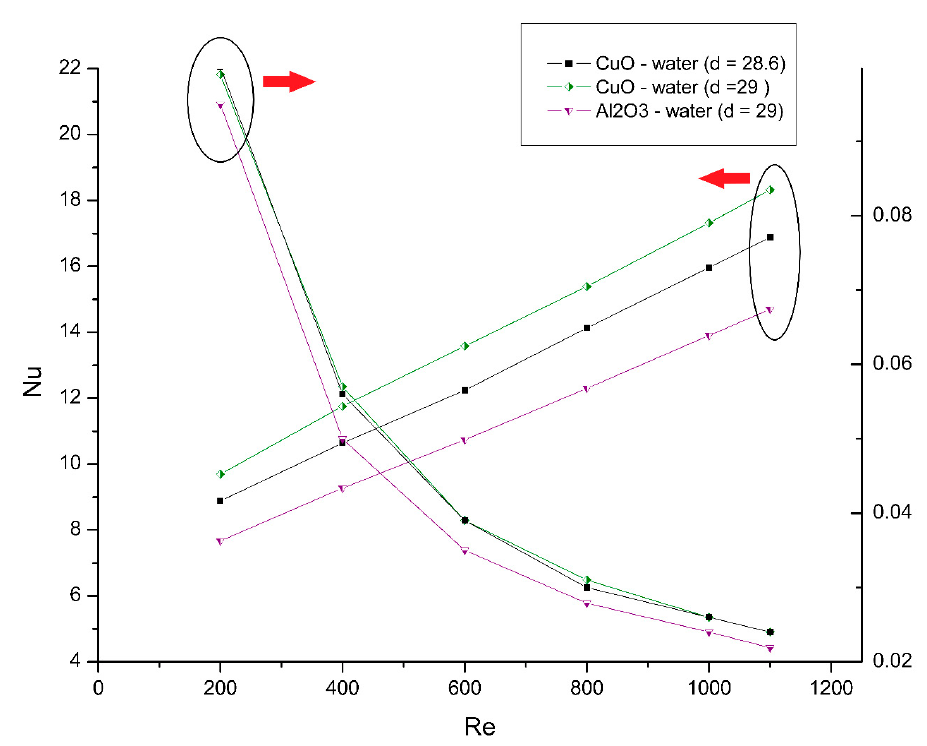
Figure 12. Variation of Nusselt number and Fanning friction with Reynolds number for various nanoparticle material and Reynolds numbers.